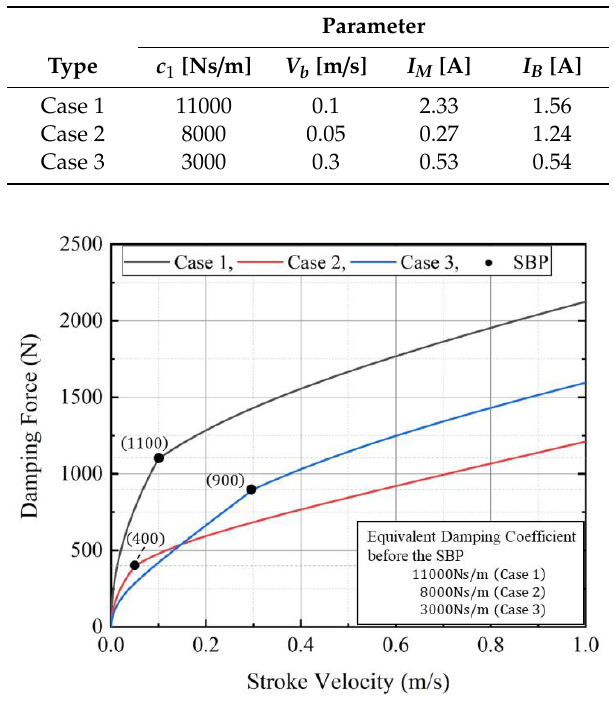
Figure 16. Three examples of desired damping characteristics.